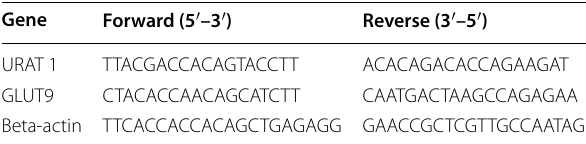
Table 1 List of primer sets used in this study